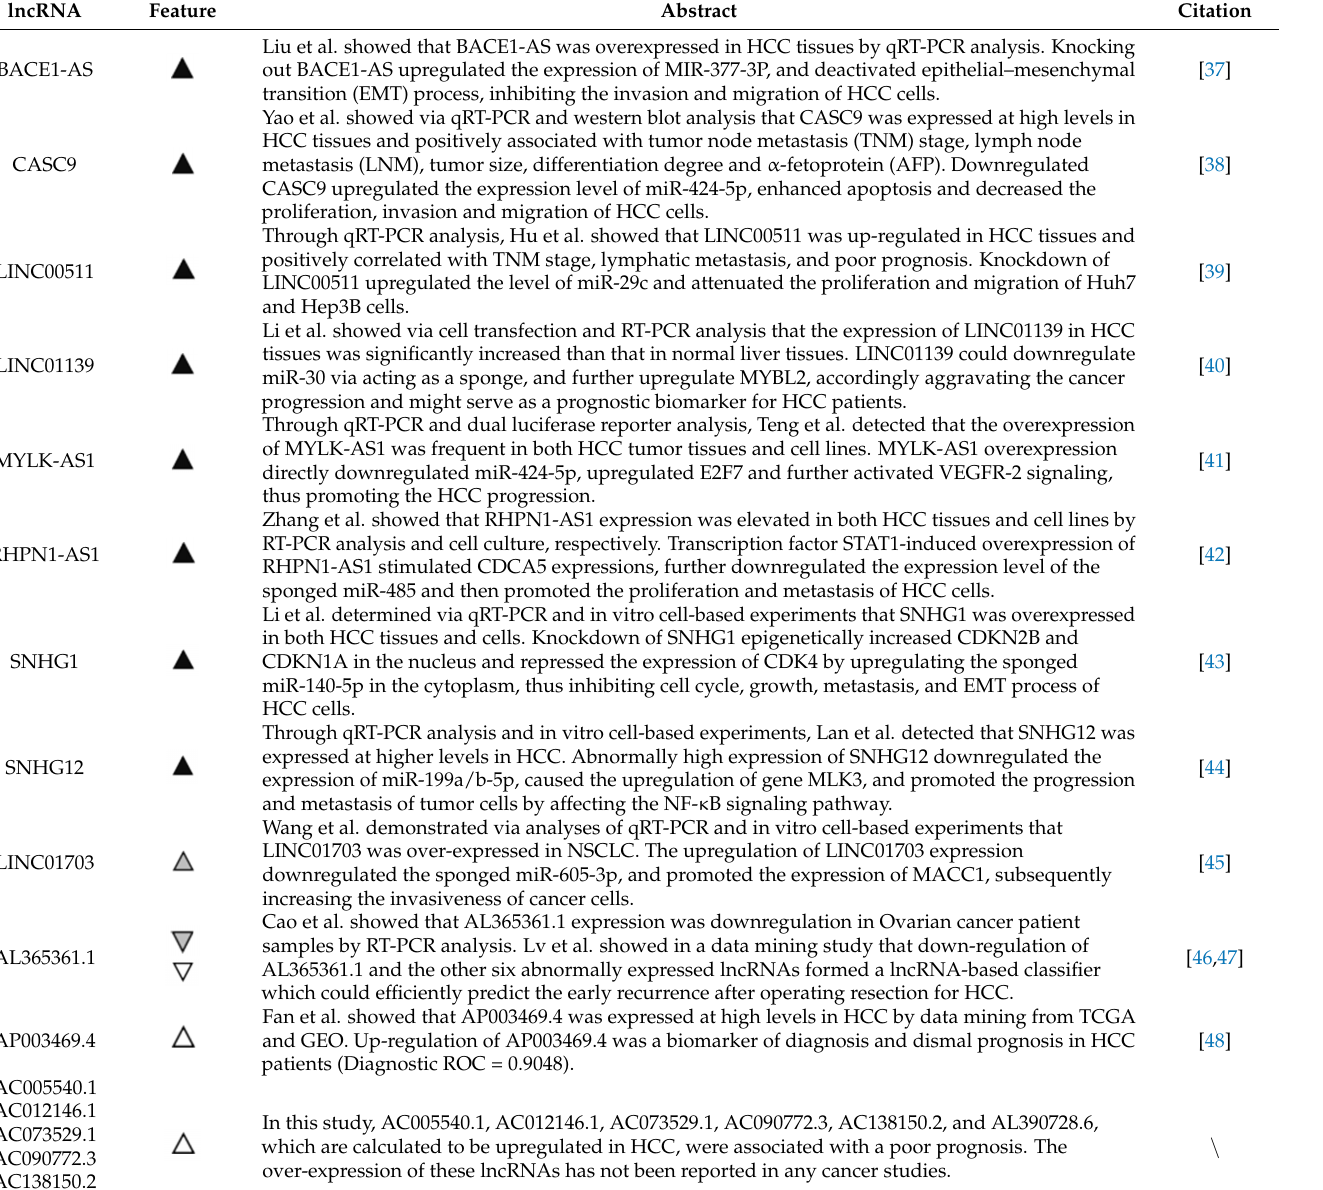
Table 4. A comparison between the abnormal expressions of seventeen prognostic lncRNAs reported in this study and previous